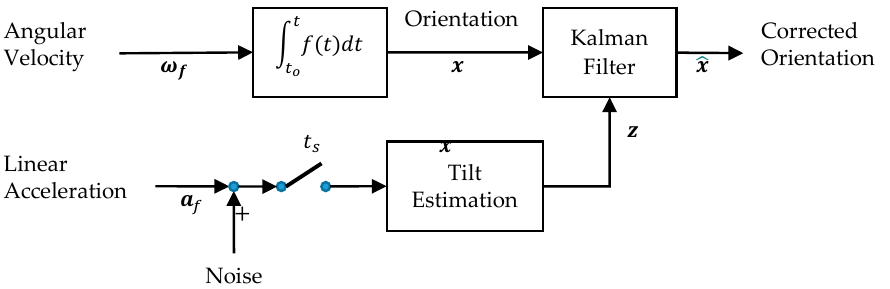
Figure 2. Angular velocity components measured by the gyroscope are integrated once to obtain orientation estimates x . The accelerometer components are used to estimate tilt (roll and pitch) during stationary periods t s . The Kalman filter bounds the tilt errors by fusing the gyro-based orientation and accelerometer-based tilt to establish the “corrected orientation” ˆ x .